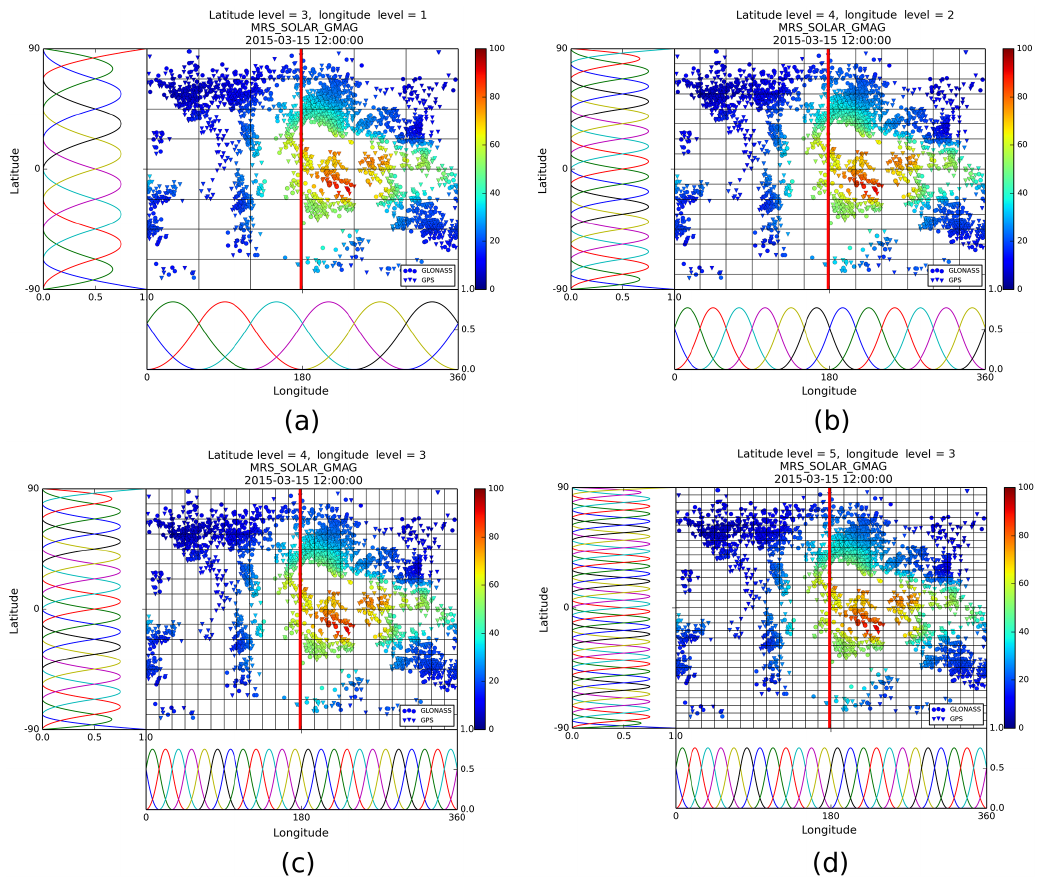
Figure 1. Global VTEC representation in a solar geomagnetic coordinate system using different resolution levels; (a) J 1 = 3 ,J 2 = 1; (b) J 1 = 4 ,J 2 = 2; (c) J 1 = 4 ,J 2 = 3; (d) J 1 = 5 ,J 2 = 3. The circles and triangles represent the data locations for GLONASS and GPS, respectively, and the colors indicate the corresponding VTEC magnitudes related to the ionospheric pierce points (IPP) obtained from (λ) with a reference map. In all the four panels at the bottom and on the left side the K J trigonometric B-spline functions T 2 J 2 ,k 2 2 − 1 and the K J − 1 are visualized. The straight black k 2 = 0 , 1 ,...,K J (ϕ) with k 1 = 0 , 1 ,...,K J polynomial B-spline functions N 2 J 1 ,k 1 2 1 1 lines on the maps show the corresponding knot point locations. The red line shows the prime meridian at